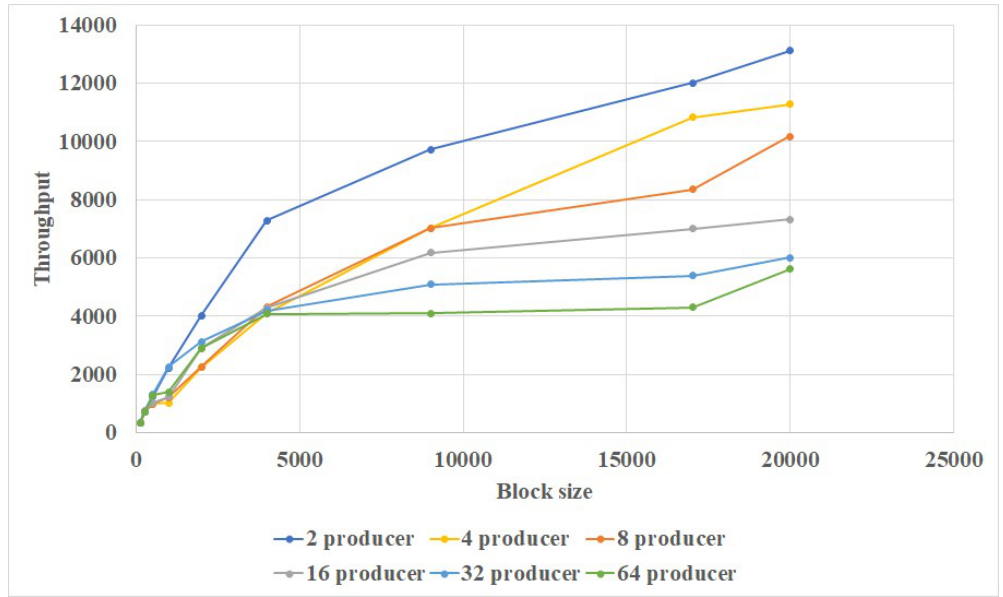
Figure 6. Relationship of throughput and block size.